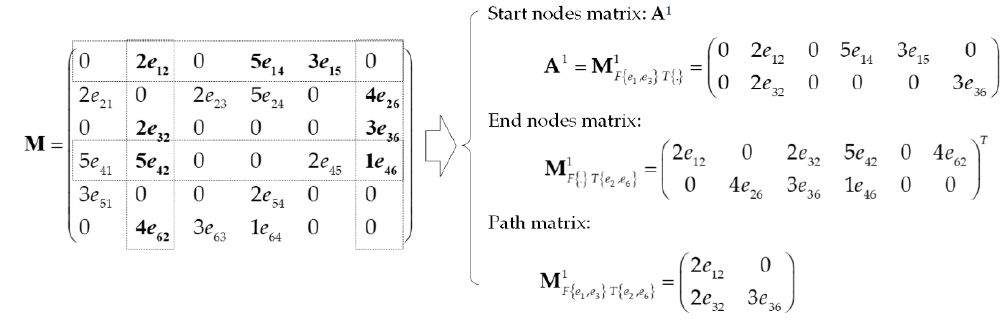
Figure 3. Path matrix construction from the adjacency matrix.